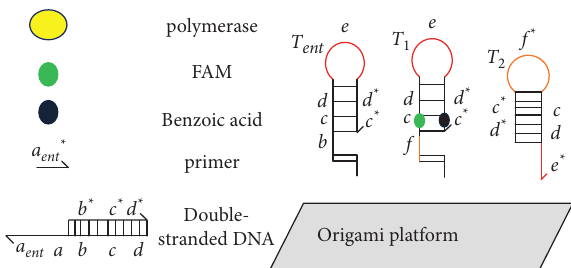
Figure 4: Materials needed to build AND